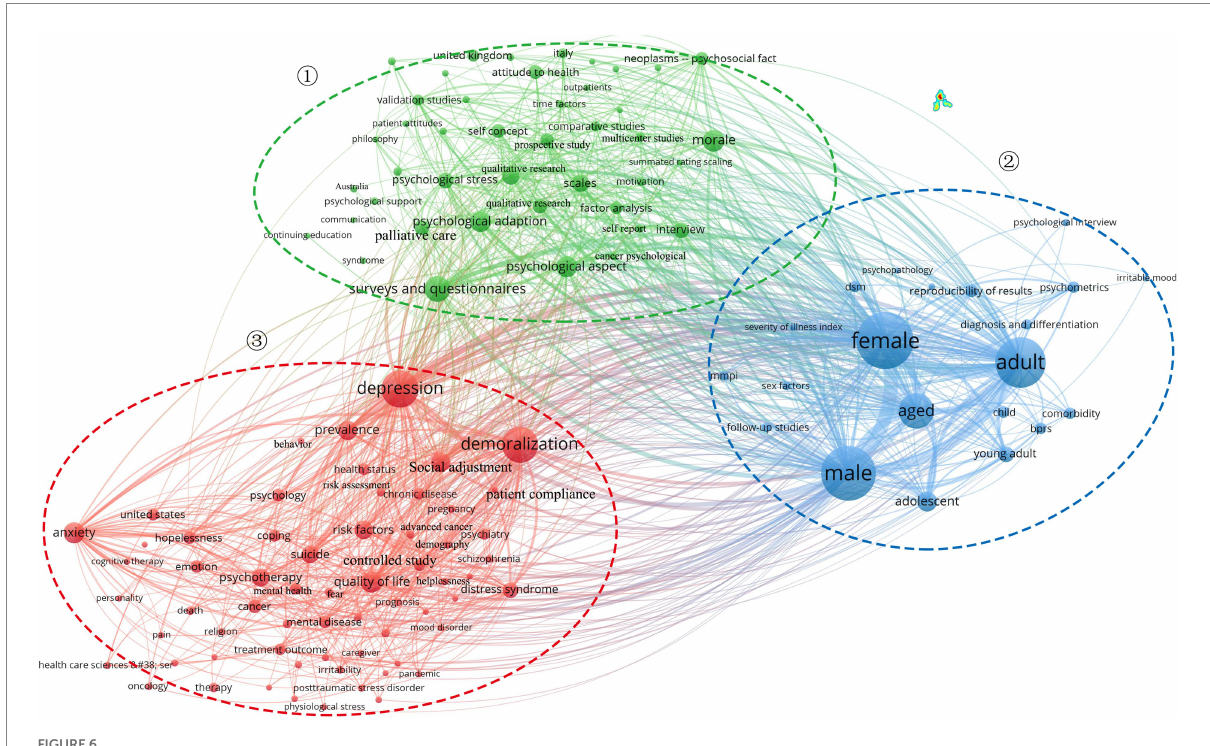
FIGURE 6 Research hotspot direction and clustering.